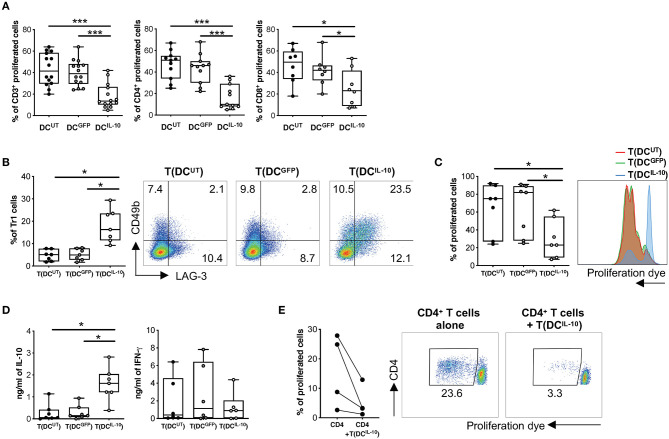
DCIL−10 promote Tr1 cell differentiation in vitro. (A) Differentiated DC were used to stimulate at 10:1 ratio allogeneic CD3+, CD4+, and CD8+ T cells isolated from peripheral blood of healthy subjects and stained with proliferation dye. Proliferation was assessed by dye dilution after 5 days. Each dot represents a single donor (n = 14), lines indicate median, while whiskers are minimum and maximum levels. (B) Allogeneic CD4+ T cells were isolated from peripheral blood of healthy subjects and stimulated with DC at 10:1 ratio for 10 days. After culture, T cells cultured with DCUT [T(DCUT)], with DCGFP [T(DCGFP)] or with DCIL−10 [T(DCIL−10)] were collected and the frequency of CD49b+LAG-3+ Tr1 was evaluated by flow cytometry. Each dot represents a single donor (n = 7), lines indicate median, while whiskers are minimum and maximum levels (left panel). Dot plots from one representative donor are shown. Percentages of positive cells are indicated (right panel). (C,D) After culture, T(DCUT), T(DCGFP), and T(DCIL−10) cells were purified by positive selection and stained with a proliferation dye prior to re-stimulation with mDC, differentiated from the same donor used in primary stimulation. At day 3 proliferation was evaluated by flow cytometry (n = 7). Percentage of proliferated cells in the precursor population was calculated (left panel) and histograms from one representative donor are shown (right panel) (C). IL-10 and IFN-γ in cell culture supernatants was evaluated by ELISA (n = 7) (D). Each dot represents a single donor, lines indicate median, while whiskers are minimum and maximum levels. *P ≤ 0.05, (Wilcoxon matched pairs test, two-tailed). (E) CD4+ T cells autologous to CD4+ cells used in primary stimulation were stimulated with mDC, differentiated from the same donor used in primary stimulation, in presence or absence of T(DCIL−10) cells at 1:1 ratio. Percentage of proliferated cells at the end of the culture was calculated by overall proliferation dye dilution. Each dot represents a single donor (n = 4), lines indicate median, while whiskers are minimum and maximum levels. *P ≤ 0.05 (Wilcoxon matched pairs test, two-tailed) (left panel). Dot plots from one representative donor are shown and percentages of gated cells are indicated (right panel). *P ≤ 0.05, ***P ≤ 0.001 (Wilcoxon matched pairs test, two-tailed).